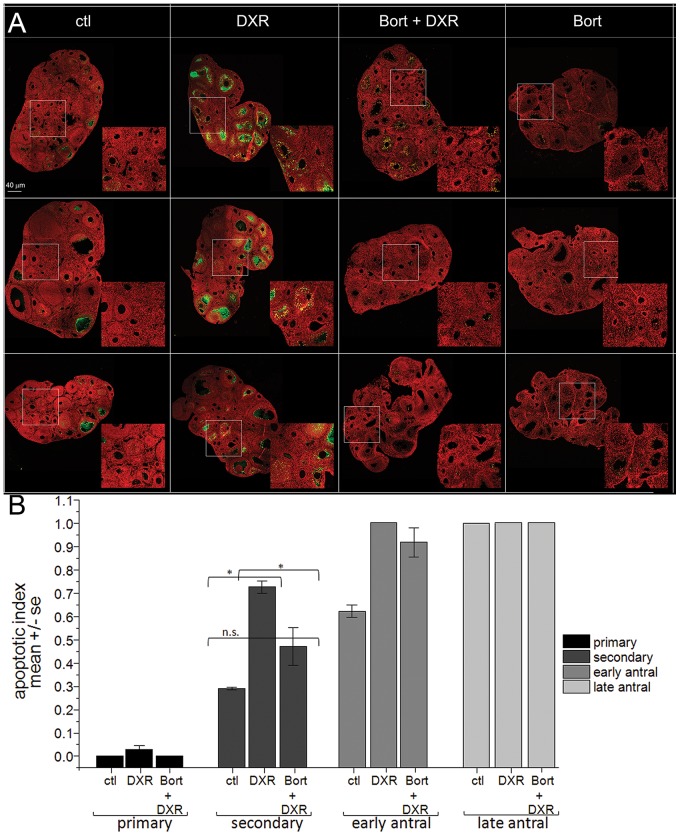
Bort pretreatment prevented DXR-induced apoptosis in mouse ovarian follicles.
A. Micrographs of mouse ovaries stained with TUNEL (green) or PI (red, nuclei), bar  = 40 µm). Representative images from 3 different mice are shown for each treatment condition. Insets are digital magnification. B. Bar graph quantifies the apoptotic index per follicle class calculated as fraction apoptotic/total follicles for each class. n = 4 mice *p<0.05, one-way ANOVA, Bonferroni means comparison. The very low levels of TUNEL-positive follicles in Bort-treated mice were not quantified.